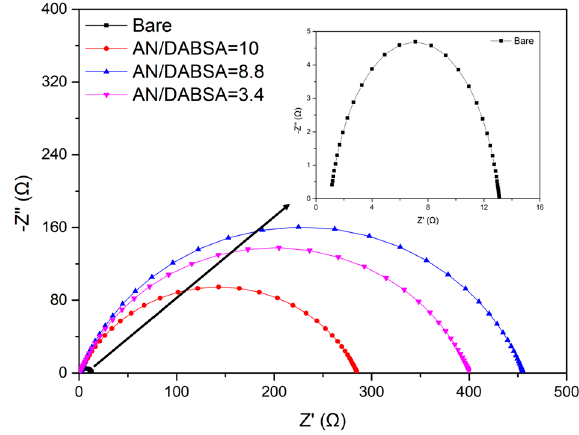
Figure 9. Nyquist plots of bare and SPAN-deposited mild steels with different AN/DABSA ratios in 1 M HCl.